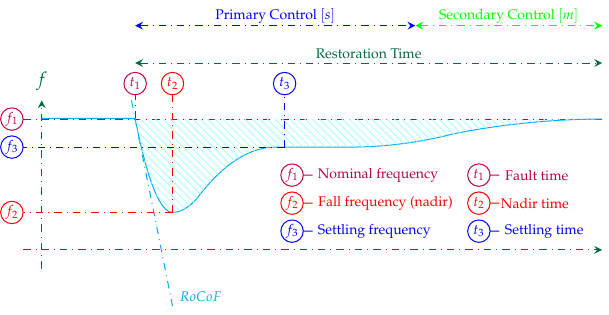
Figure 1. Power System Frequency